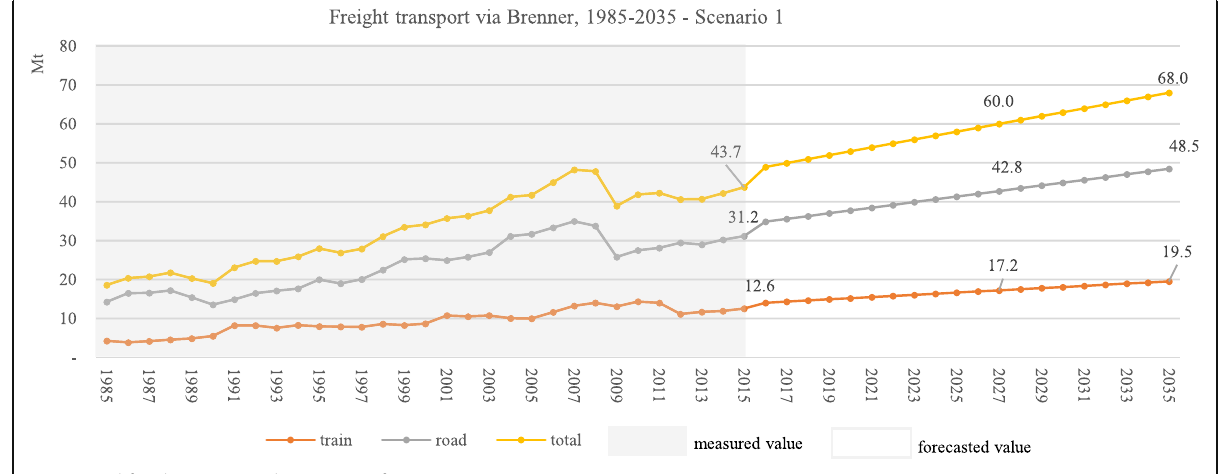
Fig. 4 Total freight transported via Brenner from 1985 to 2035 – Scenario